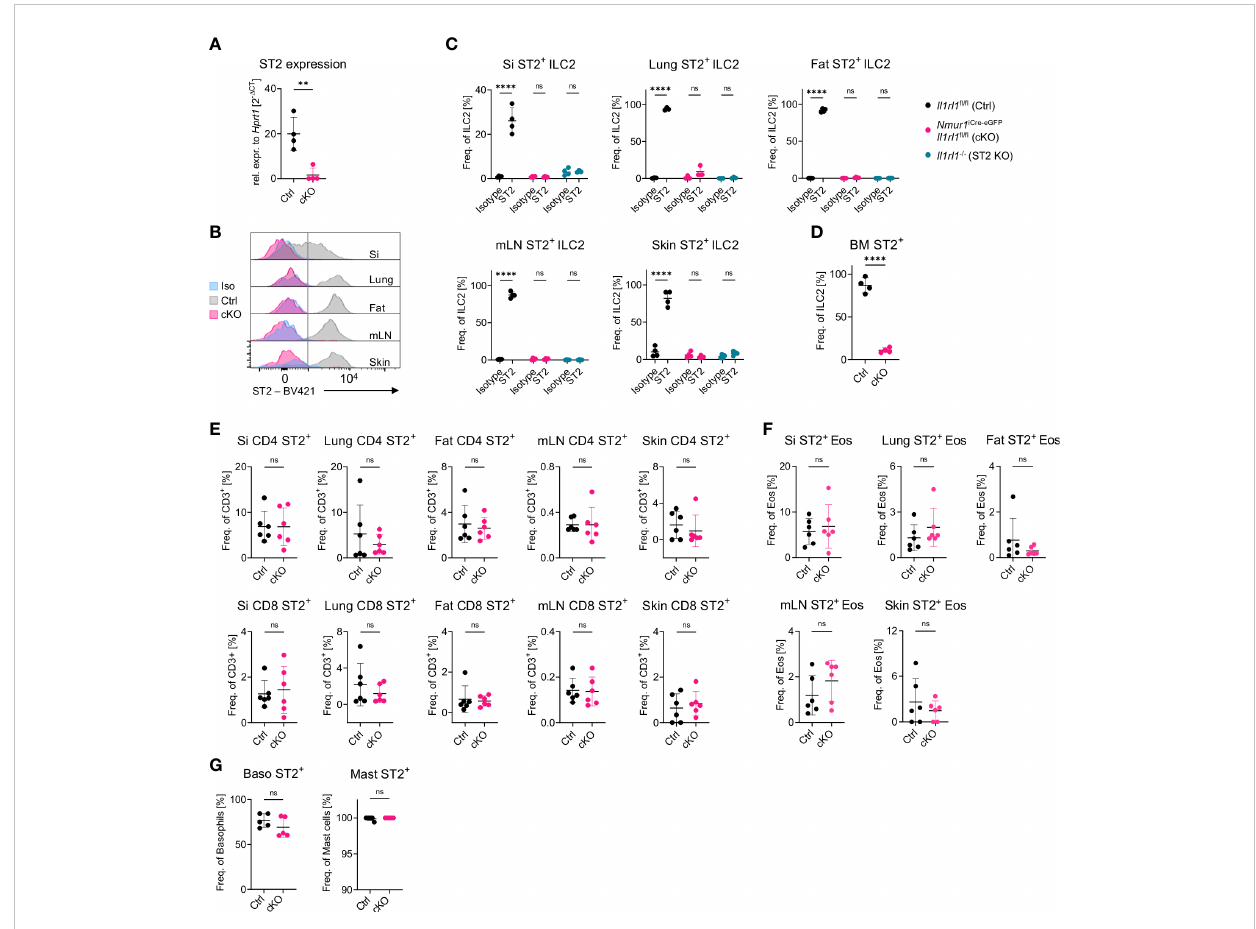
FIGURE 1 A model for ILC2-speci fi c genetic ablation of ST2. (A) , Expression of the Il1rl1 gene in Il1rl1 fl ox/ fl ox (Ctrl) and Nmur1 iCre-eGFP Il1rl1 fl ox/ fl ox (cKO) sort- puri fi ed ILC2s. (B) , Flow cytometric histograms of ST2 expression in ILC2s of Il1rl1 fl ox/ fl ox (Ctrl) and Nmur1 iCre-eGFP Il1rl1 fl ox/ fl ox (cKO) mice across organs, including isotype control on Il1rl1 fl ox/ fl ox (Iso) in the steady state. ILC2s were gated on live CD45 + Lin - (CD3, CD5, CD19, Ly6G, Fc ϵ r1), CD127 + and KLRG1 + . (C – G) Percentage of ST2 + expression in Il1rl1 fl ox/ fl ox (Ctrl), Nmur1 iCre-eGFP Il1rl1 fl ox/ fl ox (cKO) (D – G) and Il1rl1 -/- (ST2 KO) mice including isotype control (C) across different organs in the indicated immune cells. Basophils from spleen and mast cells from the peritoneal lavage. For (C – G) : Each symbol represents data from one mouse, data are representative of two experiments with four to six mice per group. Mean +/- SD, Student ’ s t-Test. ns, not signi fi cant, **p < 0.01, ****p <